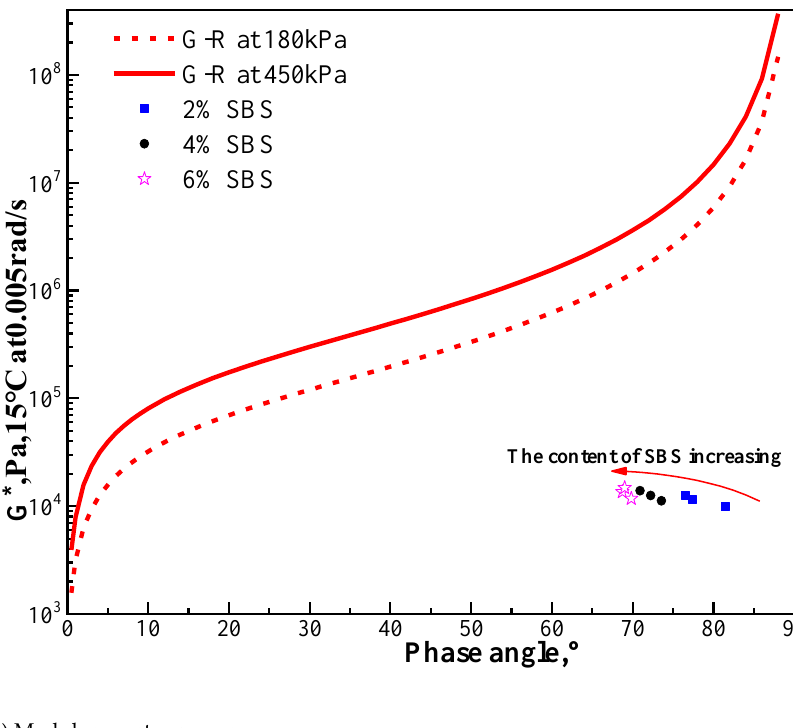
Figure 2. Modulus master curves of 6L-0.3S-2R and 2L-0.15S-2R samples.